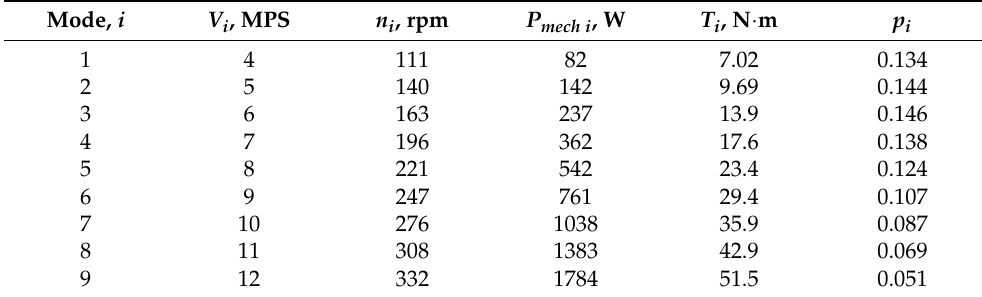
Table 1. Initial nine-modes profile of the wind generator. n i : rotational speed; P mech i : mechanical power; T i : torque; V i : wind speed; p i statistical probability of an i -th mode.